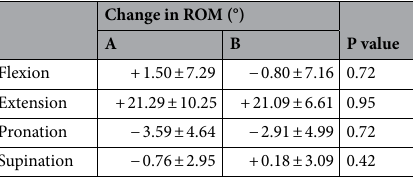
Table 4. Comparison of two group in ROM (preoperative vs follow-up) in